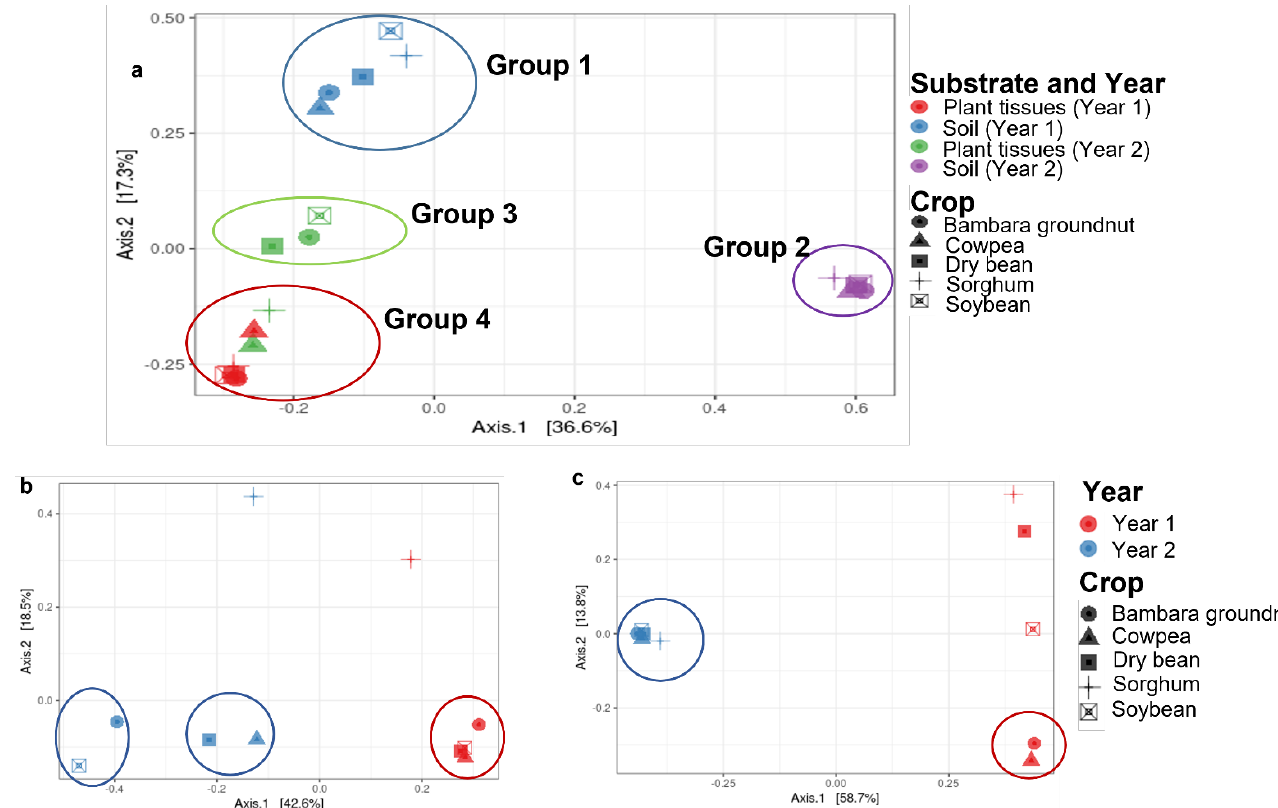
Figure 1. Principal coordinate analysis (PCoA) for the fungal communities from plant tissue and soils of sorghum and legumes over two years. All substrates ( a ), plant tissues ( b ), and soil ( c ).